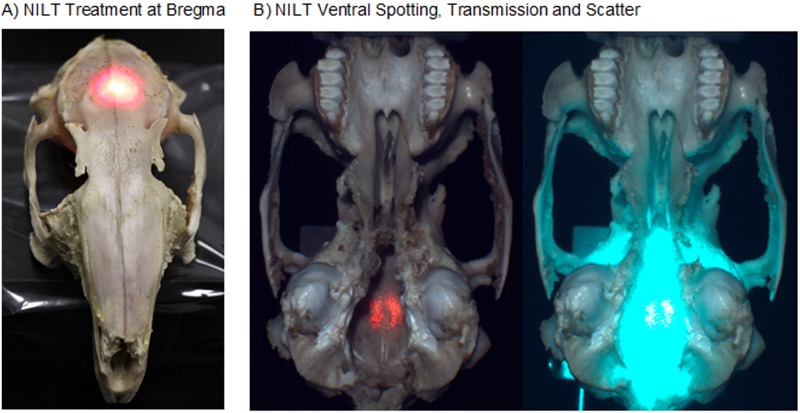
Dehydrated Rabbit Skull NILT Transmission.(A) NILT Treatment at Bregma showing the laser spotting light, (B) NILT Penetration and Scatter- Ventral surface of the rabbit skull showing the NILT penetration profile (A) and extensive diffusion pattern observed (B).